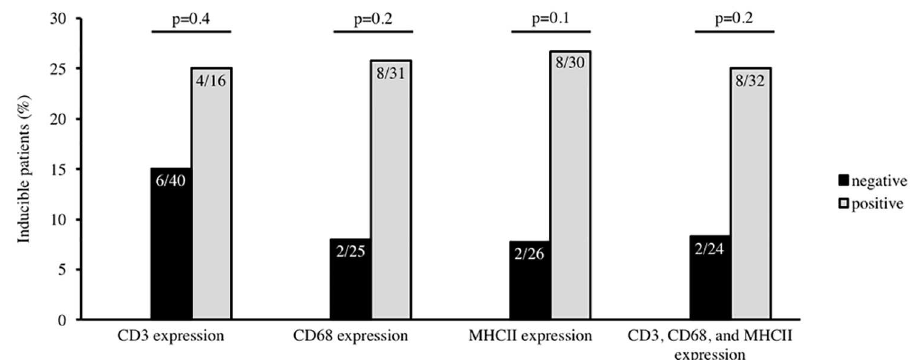
Fig 1. Association between ventricular inducibility and immunohistochemical markers of inflammation detected in endomyocardial biopsy. There was no significantassociationbetweenthe presenceof the inflammatory marker CD3 and ventricularinducibility(p = 0.4), CD68and ventricular inducibility (p = 0.2), MHCII and ventricularinducibility(p = 0.1), and the combination of all inflammatory markers (CD3, CD68, and MHCII) within the myocardium and ventricular inducibility(p = 0.2).